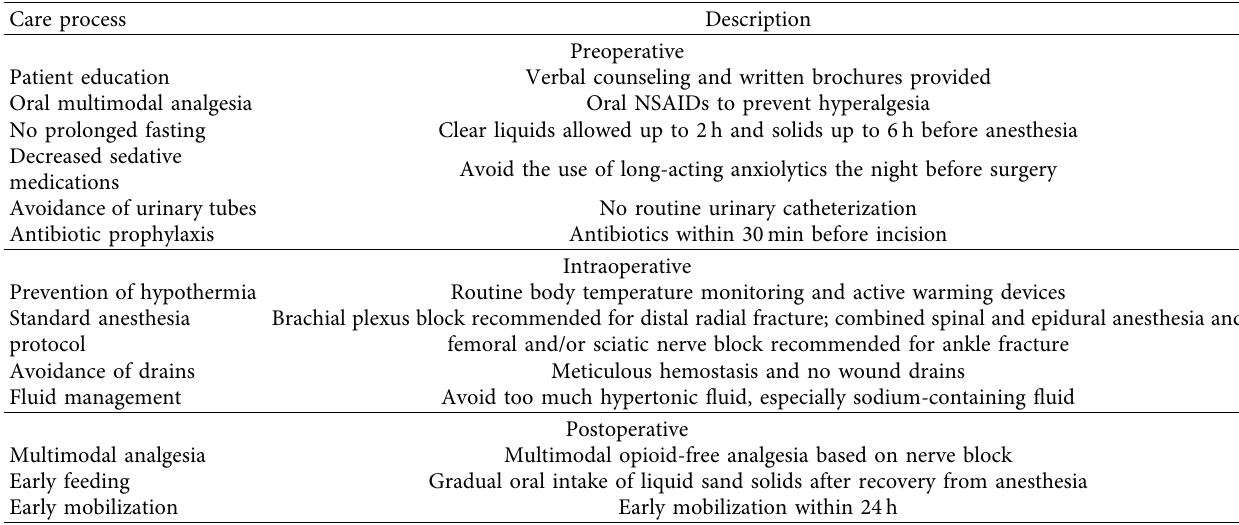
Table 1: ERAS pathway of ankle and distal radial